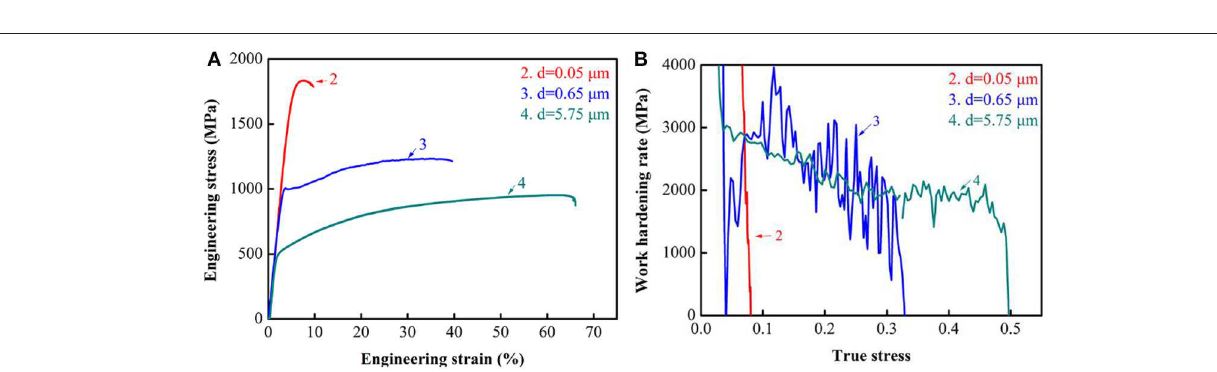
Frontiers in Materials |